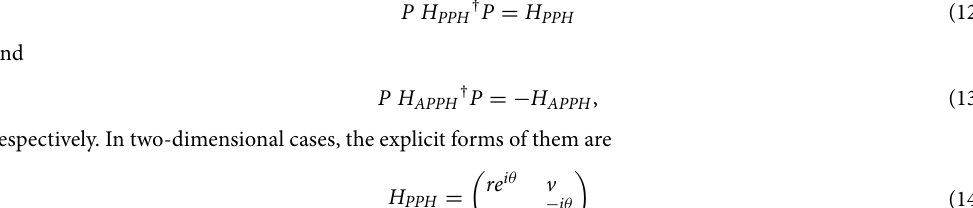
which are either purely real or imaginary. For PT- or anti-PT-symmetric systems, the Hamiltonian may be exact or spontaneously broken, depend- ing on whether the eigenstates of the Hamiltonian are also invariant under the PT-symmetry transformation or not. In the theoretical model of (anti-)PT-symmetry, we treat the two cases as PT-unbroken and PT-broken phases, which are separated by the EPs ( (cid:31) PT or (cid:31) APT is equal to zero). Figures 1(a) and 2(a) show the two phases and EPs for the PT- and anti-PT-symmetric two-level systems, respectively. To be consistent with the (anti) P-pseudo-Hermitian systems in the next subsection, we classify the phases of this two Hamiltonians by whether the difference of eigenvalues are real or imaginary. For convenience, we denote the PT-unbroken (or broken) phase of the PT- and anti-PT-symmetric Hamiltonians as PT(real) or PT(imaginary) and anti-PT(imaginary) or antiPT(real), respectively.